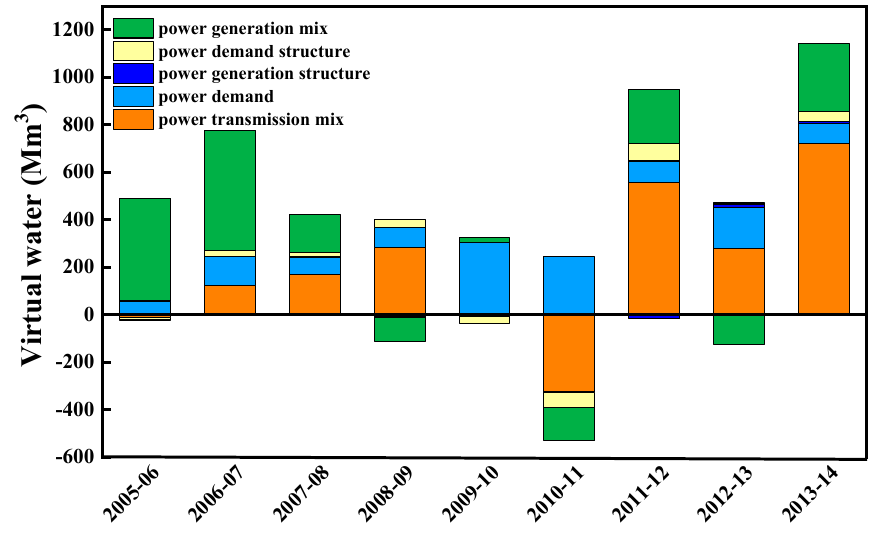
Figure 4. The contribution of driving factors to the changes of virtual water transmission.